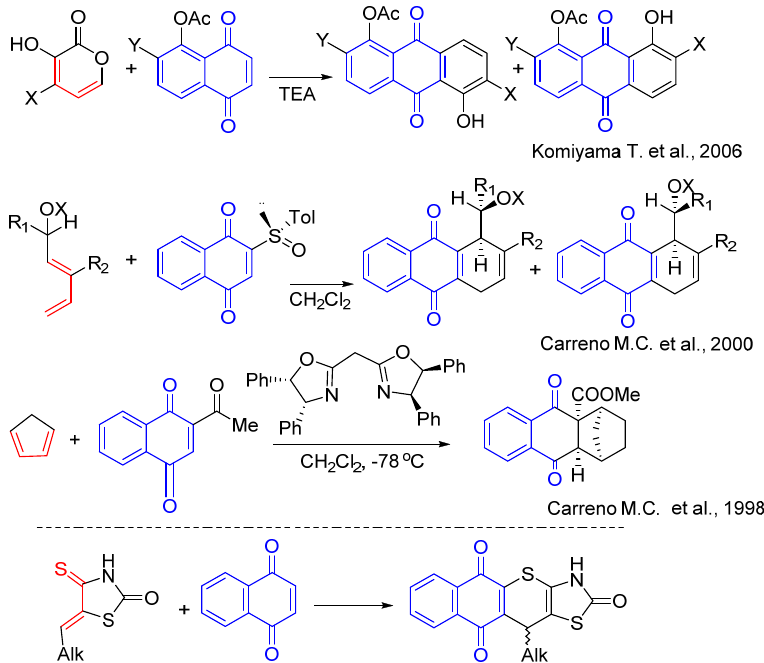
Figure 2. Background for targeted compound synthesis [29–31].